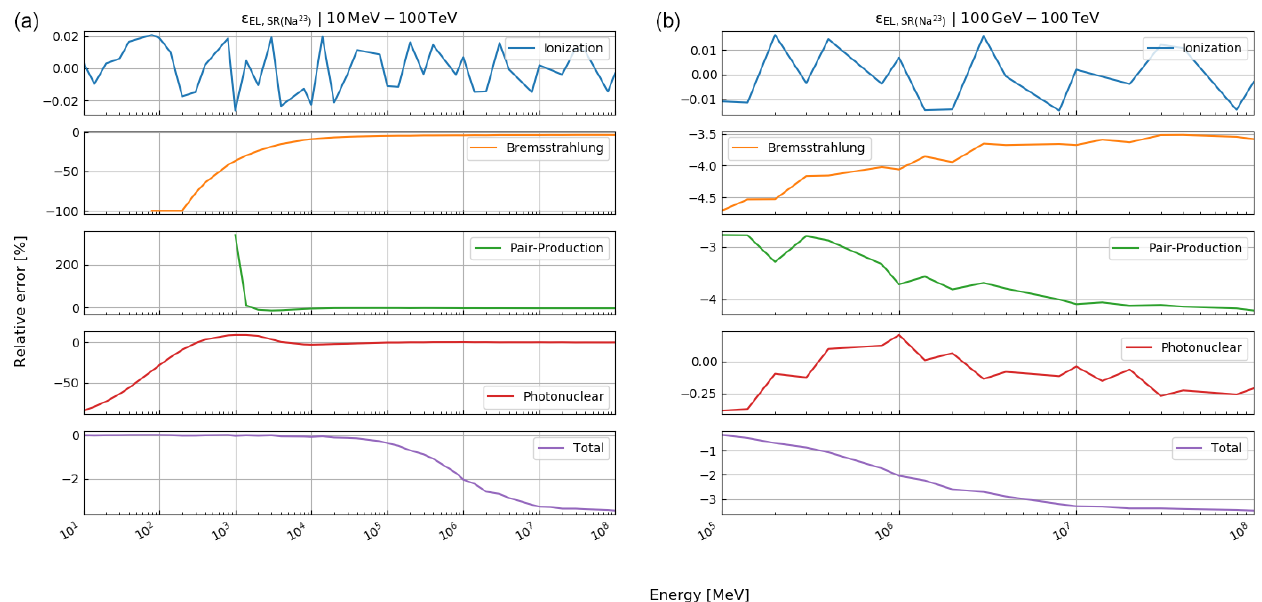
Figure E4. Relative error of our energy loss calculations compared to the tabulated values from Groom et al. (2001) for standard rock ( 23